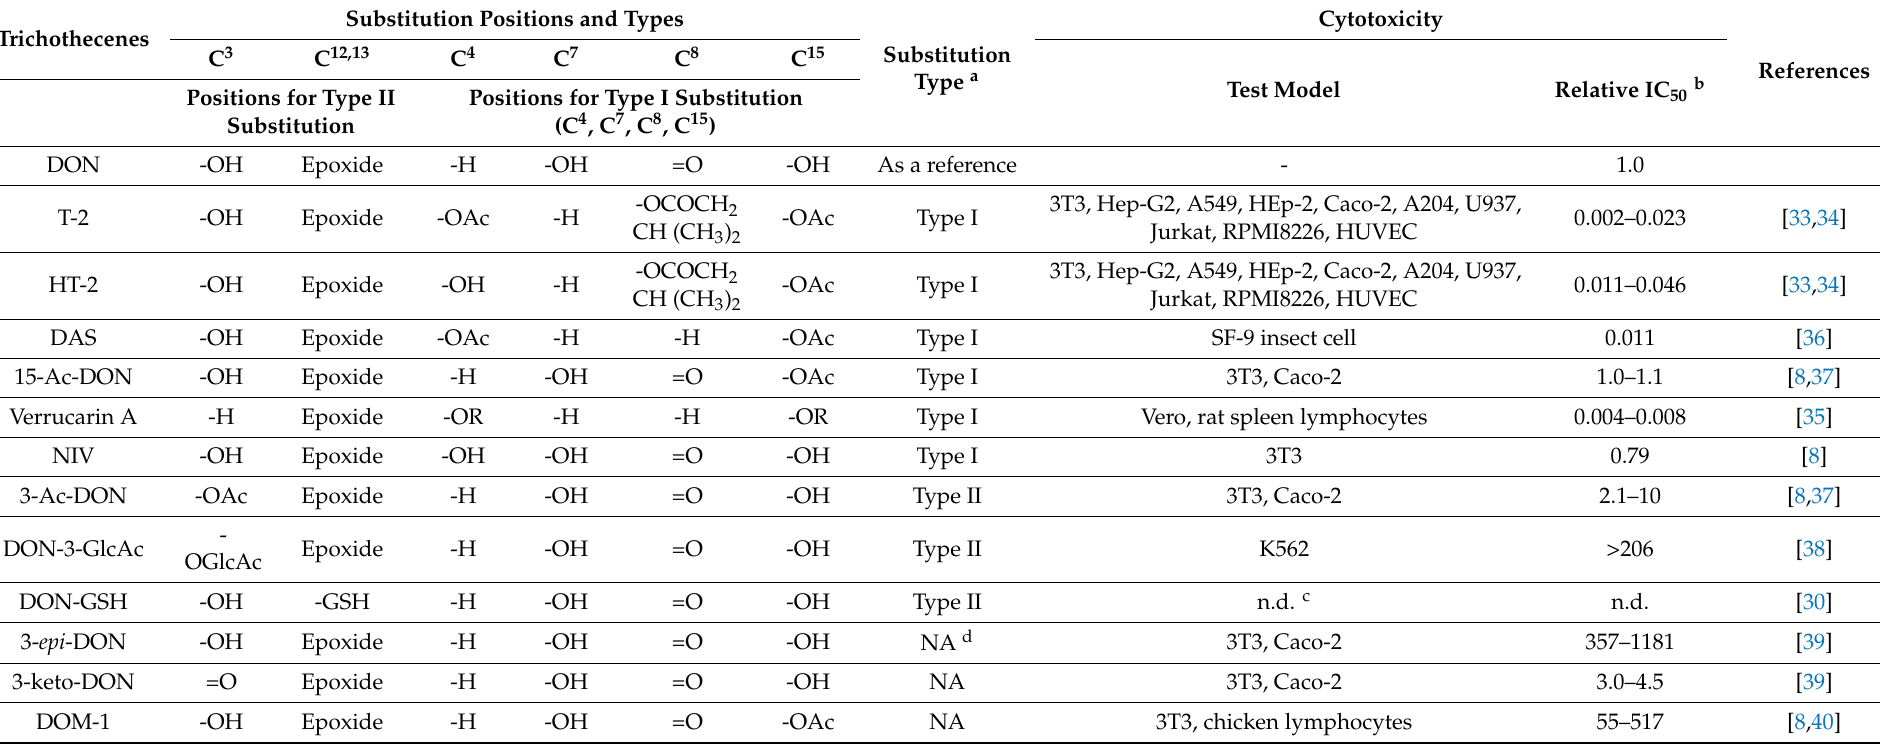
Table 2. The comparison in the substitution type and toxicity of several selected trichothecenes and their